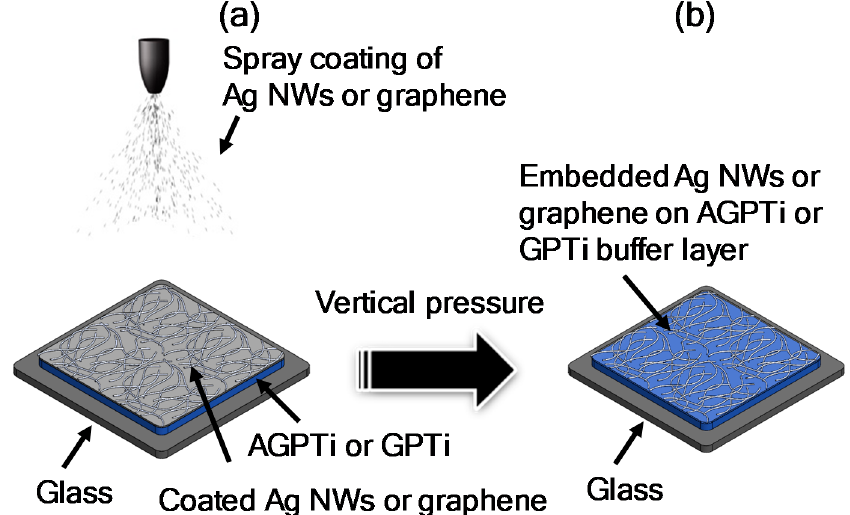
Figure 1. Fabrication of AgNW (or graphene) electrodes with high conductivities and adhesion strengths by mechanical pressing techniques on the AGPTi (or GPTi) buffer layer. ( a ) spray coating of AgNWs or graphene, ( b ) applying pressure to the film.